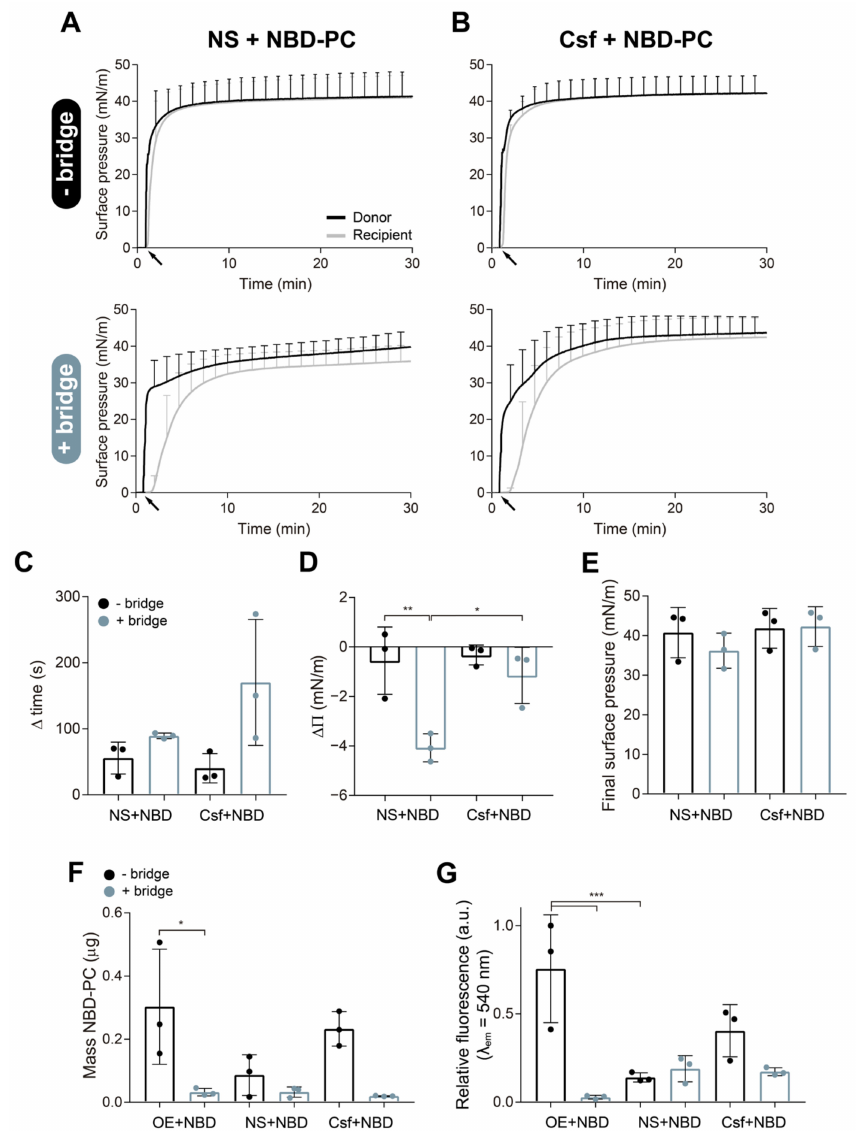
Figure 3. Effect of the interfacial bridge on the spreading and membrane transference of different materials over the air–liquid interface. Surface pressure ( Π )-time isotherms upon interfacial injection of 15 µ L of ( A ) native surfactant (NS) or ( B ) Curosurf (Csf) labelled with 1% (mol/mol) NBD-PC, at 20 mg/mL, at the donor compartment, performed in the absence (upper panels) and in the presence (bottom panels) of the paper bridge. Black arrows indicate material injection onto the donor interface. ( C ) Delay in the increase of surface pressure at the recipient compartment until reaching Π 50 with the two materials tested, either with (blue bars) or without (black bars) the bridge. ( D ) Difference in surface pressure between recipient and donor compartments ( ∆Π ) registered 30 min after injection of NS or Csf. ( E ) Final surface pressures reached at the recipient compartment 30 min after material addition at the donor trough. ( F ) Mass of NBD-PC ( µ g) collected from the recipient interface by aspiration calculated from a standard curve. Data from the aqueous suspension of OE have been included in this graph for comparison with the other material. ( G ) Relative fluorescence emission of NBD-PC at λ em = 540 nm measured at the recipient subphase. Fluorescence from experiments with aqueous suspension of OE has been included in this graph for comparison. Data represent mean and standard deviation calculated from a minimum of three independent experiments. One-way ANOVA followed by Tukey’s post-hoc test: ( D ) p = 0.004; ( F ) p = 0.004; ( G ) p = 0.001. (*) p < 0.05 and > 0.01, (**) p ≤ 0.01 and >0.005, and (***) p ≤